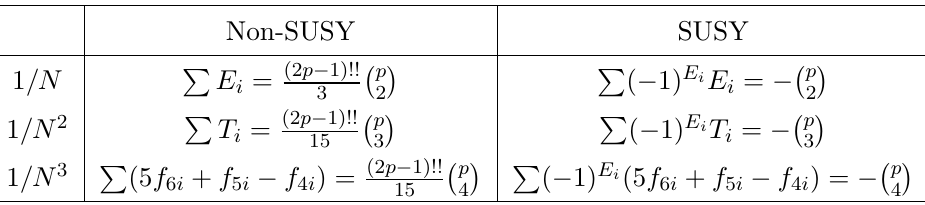
Table 3 . Some of the enumerative identities for intersection graphs generated at each order of 1 =N . All summation symbols run from i = 1 to i = (2 p (cid:0) 1)!!. is capable of enumerating the two new structures separately. Nevertheless, the old method provides an independent consistency check of the results obtained in the present paper, which will be demonstrated in appendix